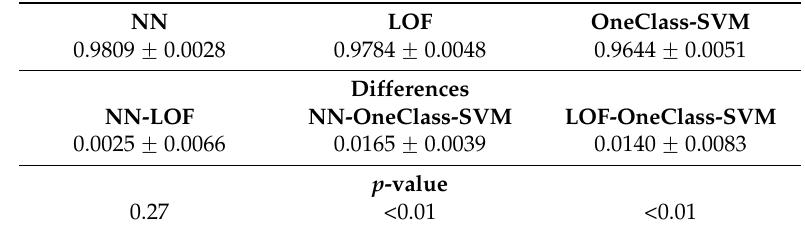
Table 1. Comparison between novelty detectors. AUC values are given as means and standard deviations. p -values were obtained with a two-sided Wilcoxon test.